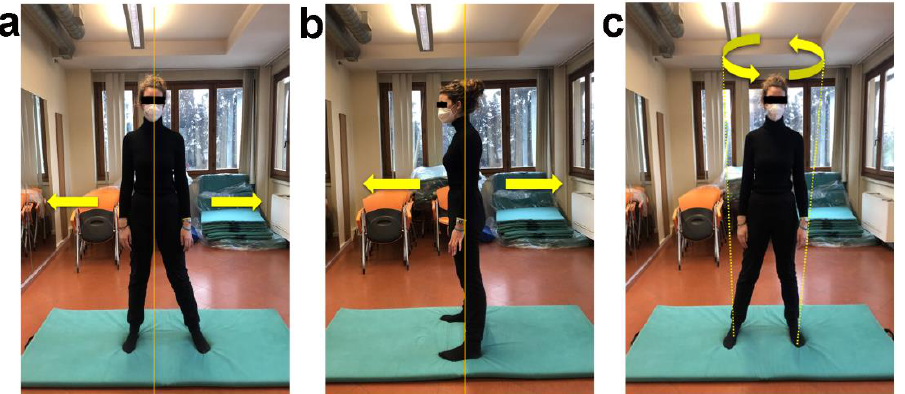
Figure 7. Postural sway on frontal, sagittal and transverse plane in orthostatic position. ( a ) Orthostatic position on a soft mat, feet hip-width apart, arms laying down on body sides. Keeping trunk aligned, shift bodyweight from one foot to the other on frontal plane (horizontal yellow arrows) without losing the ground contact. ( b ) Repeat the previously described exercise shifting bodyweight from forefeet to heels on sagittal plane (horizontal yellow arrows). ( c ) Combine the previously described exercises performing body circular sway on transverse plane (curved yellow arrows). Perform for one minute on each plane. No recovery.